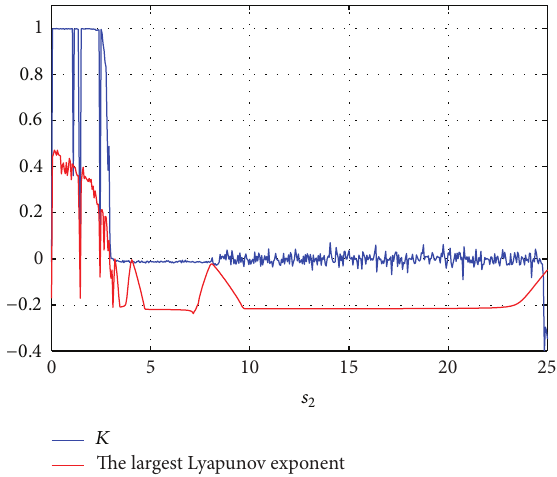
Figure 8: 𝐾 and the largest Lyapunov exponent versus 𝑠 3 ∈ [0, 25] and 𝑠 2 = 0.2 .